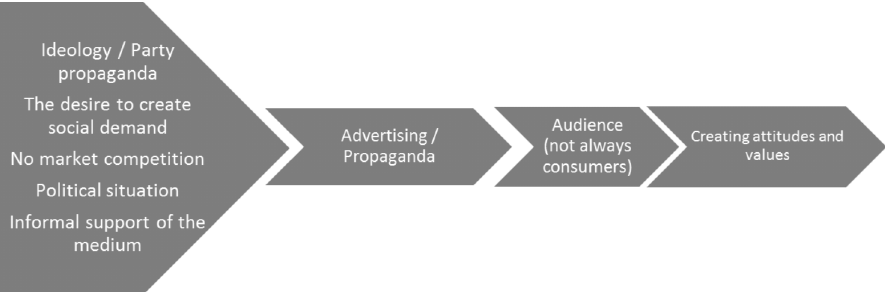
Figure 4. Model of economic propaganda in